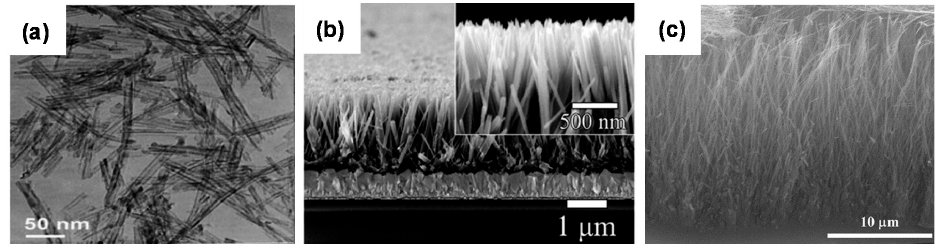
Figure 5. SEM images of 1D TiO 2 nanostructures using a hydrothermal method. ( a ) Randomly